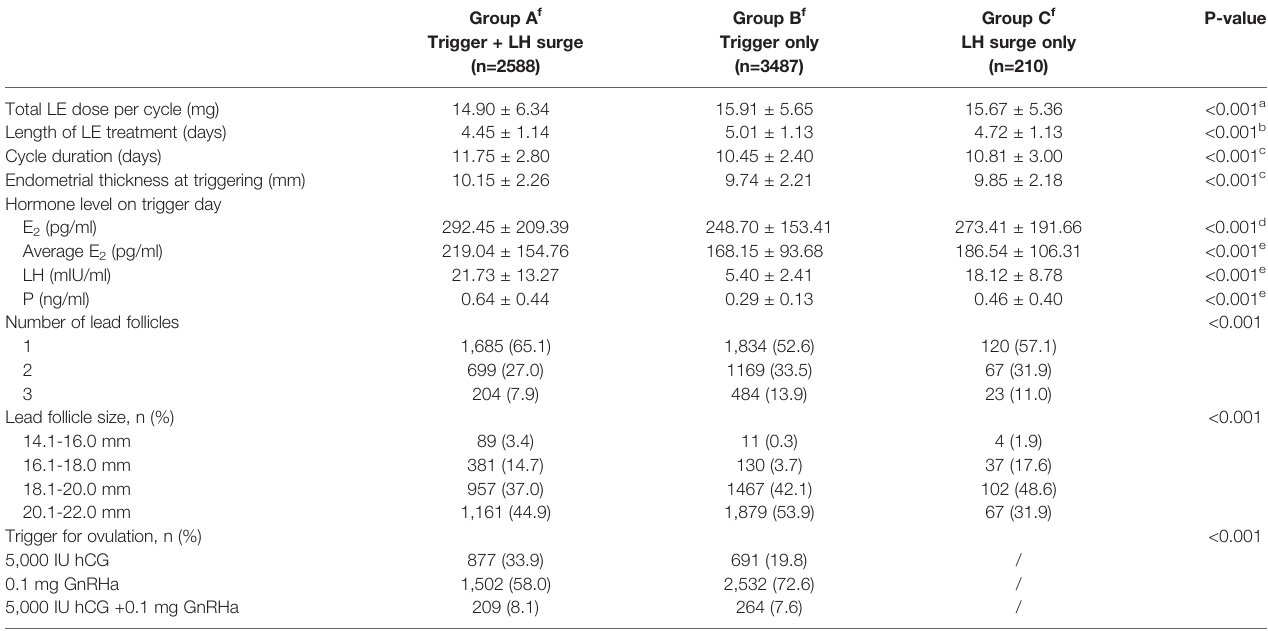
TABLE 2 | The cycle characteristics and hormone pro fi les of patients undergoing